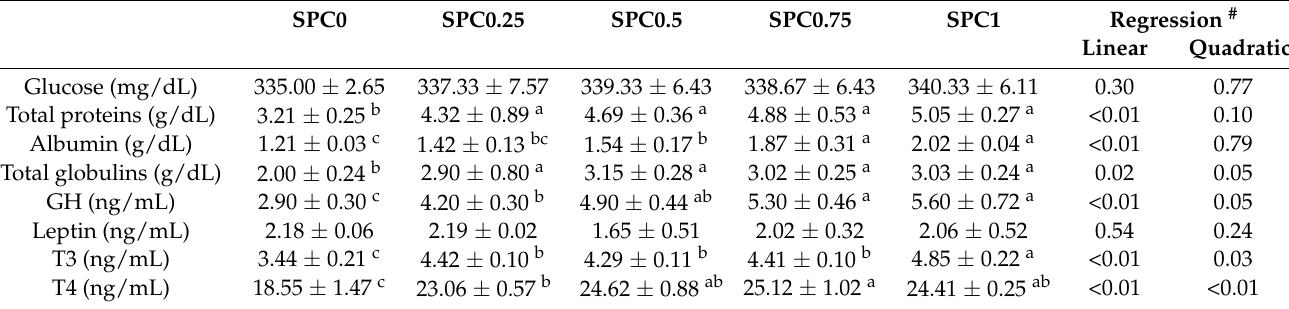
Table 3. Effect of dietary Spirulina platensis phycocyanin addition on serum biochemical parameters.